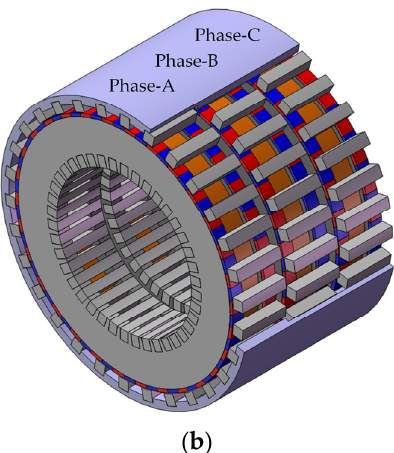
Figure 1. Basic structure of combined ‐ type stator core transverse flux motor (CS ‐ TFM): ( a ) single ‐ phase; and ( b ) three ‐ phase.